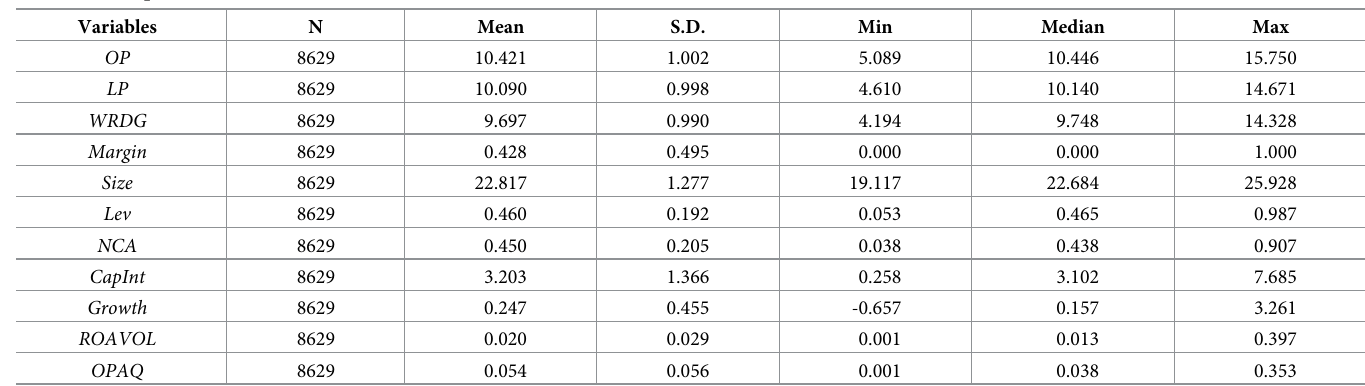
Table 3. Descriptive statistics.